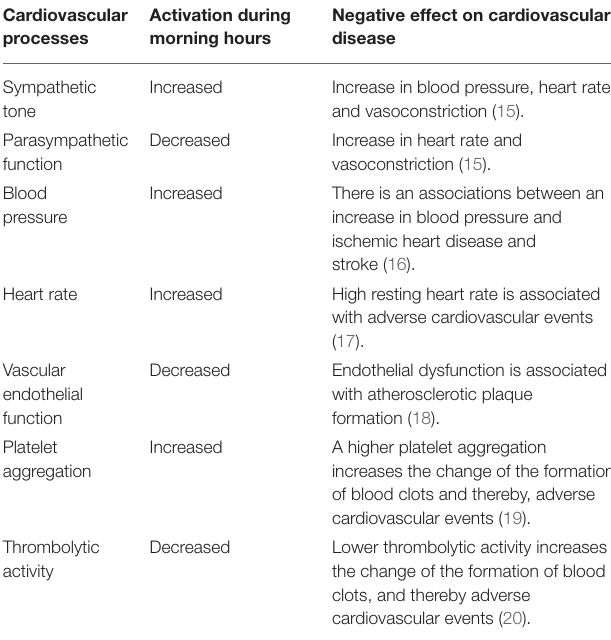
TABLE 1 | Important changes in cardiovascular processes during the